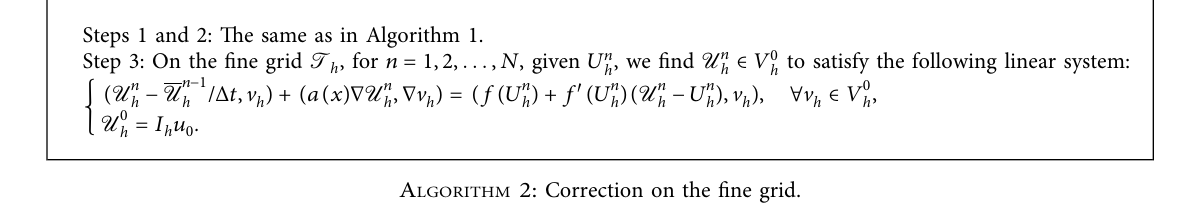
A LGORITHM 2: Correction on the fne